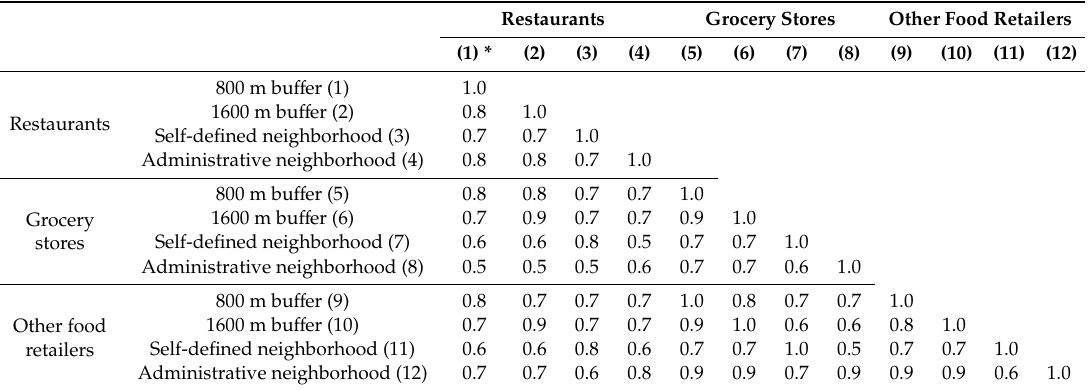
Table 4. Spearman correlation coe ffi cients for the measures of density of food retailers in the four neighborhood definitions used. Restaurants Grocery Stores Other Food